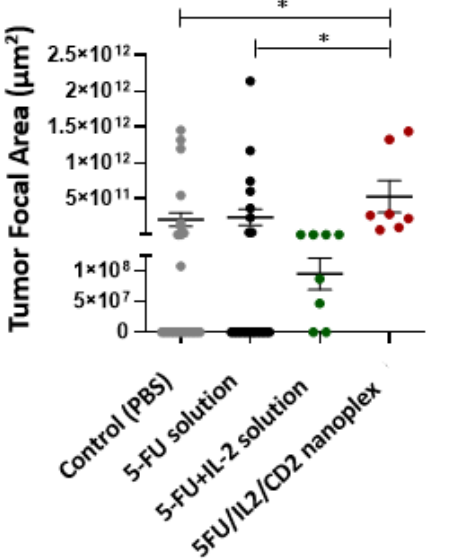
Figure 12. The primary tumor focal area in the treated groups with PBS, 5-FU solution, 5-FU+IL-2 solution and 5FU/IL2/CD2 nanoplex (* p < 0.05).